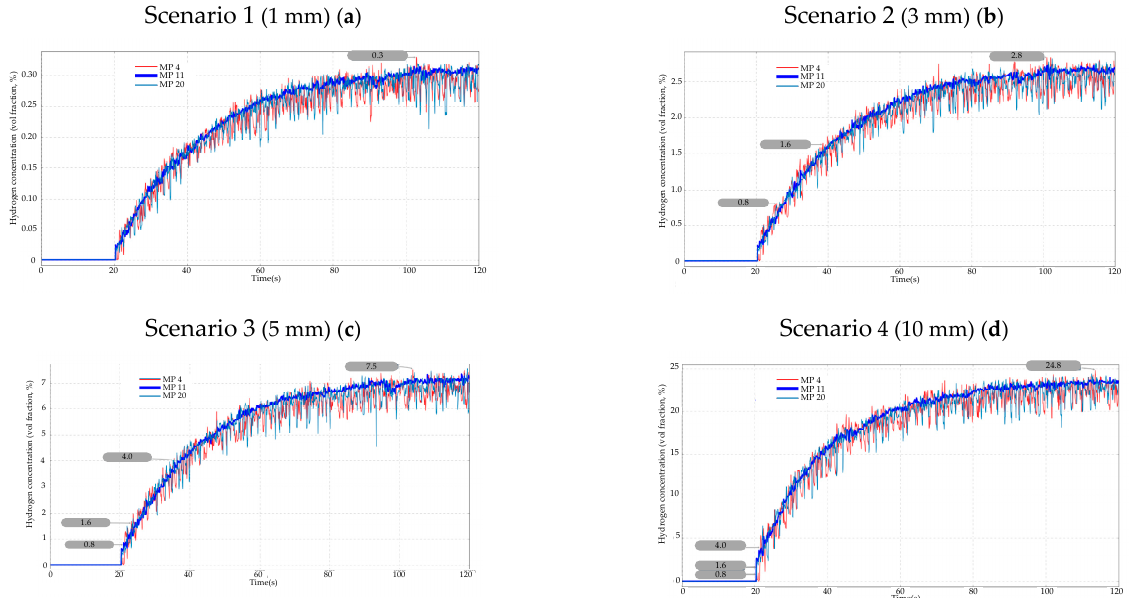
Figure 10. Changes in hydrogen concentration at MP4, MP11, and MP20 in scenarios 1, 2, 3, and 4. ( a ) Scenario 1 (leakage diameter = 1 mm); ( b ) Scenario 2 (leakage diameter = 3 mm); ( c ) Scenario 3 (leakage diameter = 5 mm); ( d ) Scenario 4 (leakage diameter = 10 mm).